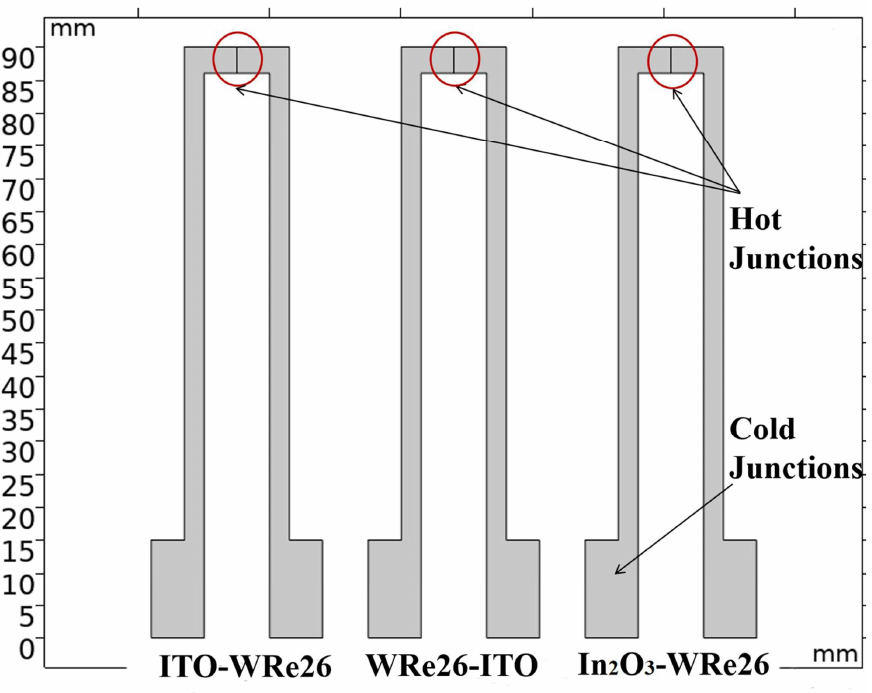
Figure 1. Simulation model of three thermocouple combinations .